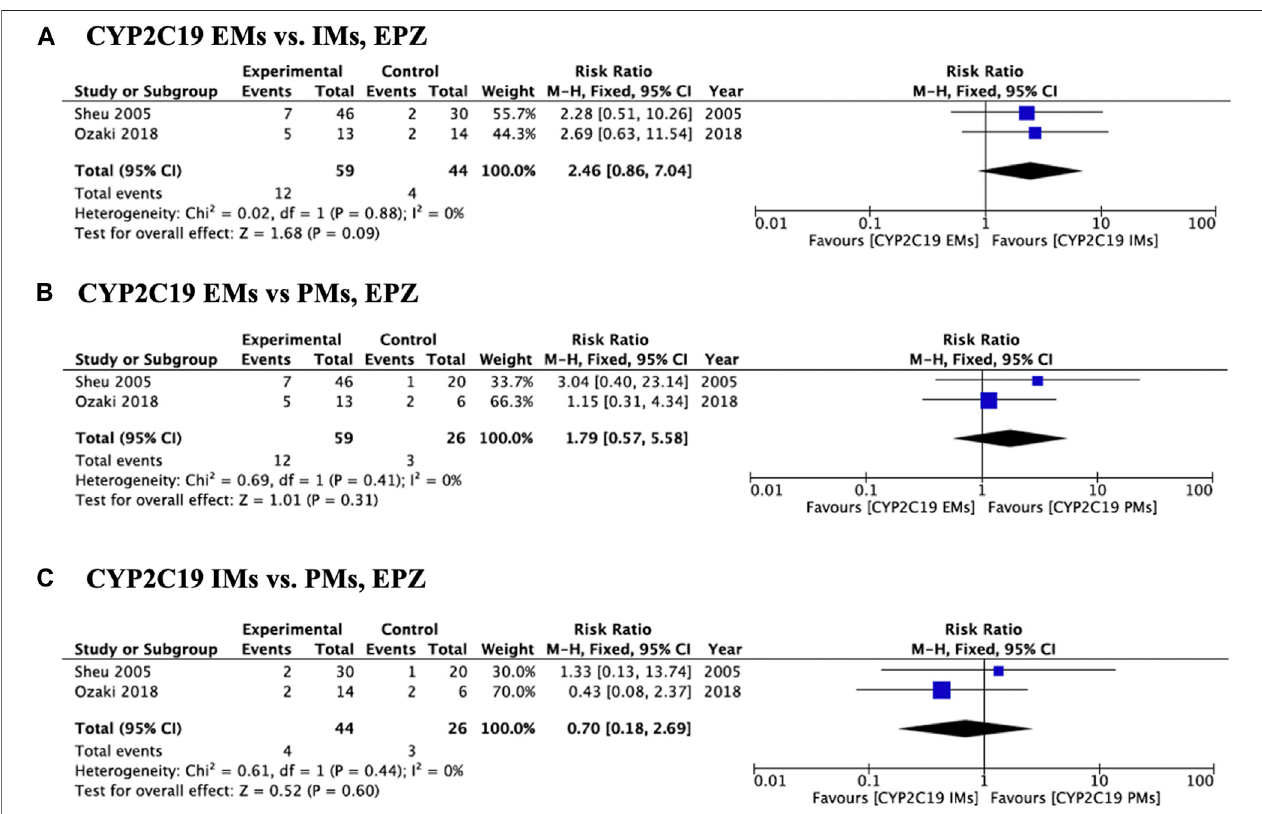
FIGURE 5 | Forest plots of H. pylori cure rates of EPZ-amoxicillin-clarithromycin regimen among different CYP2C19 genotypes in the fi xed-effects model. (A) CYP2C19 EMs vs IMs, (B) EMs vs PMs and (C) IMs and PMs.; Abbreviations: CI, con fi dence interval; EM, extensive metabolizer of CYP2C19; EPZ, esomeprazole; IM,